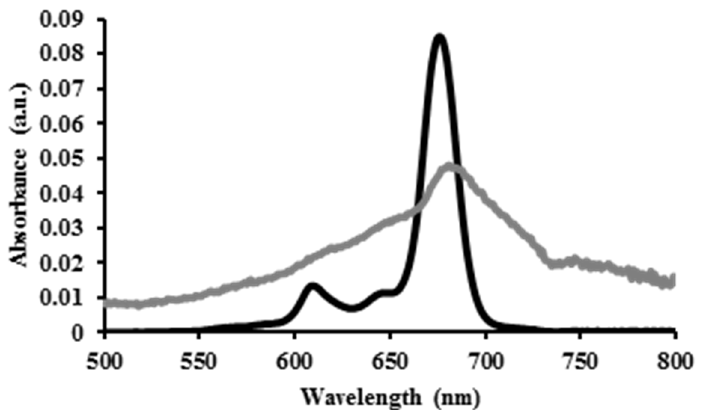
Figure 3. UV-VIS spectra of AlClPc molecules ( black ) and AlClPc-MSNs ( gray